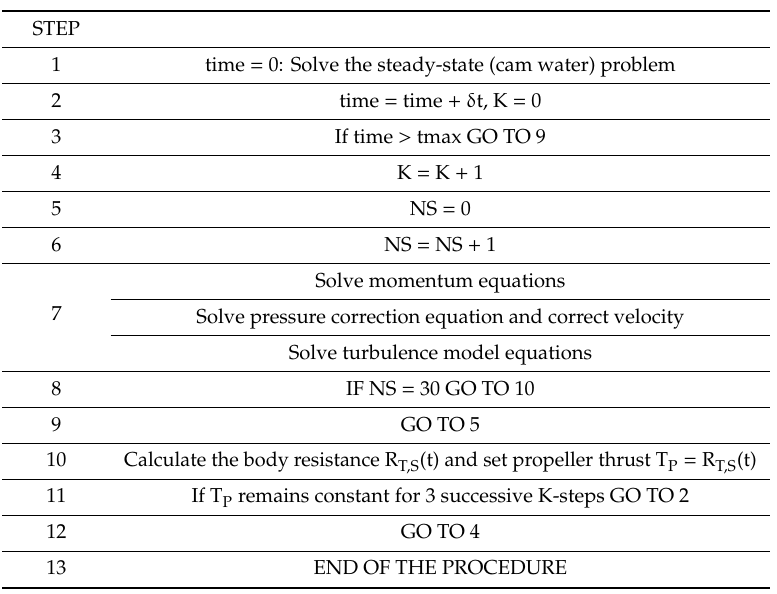
Table 1. The general algorithm.